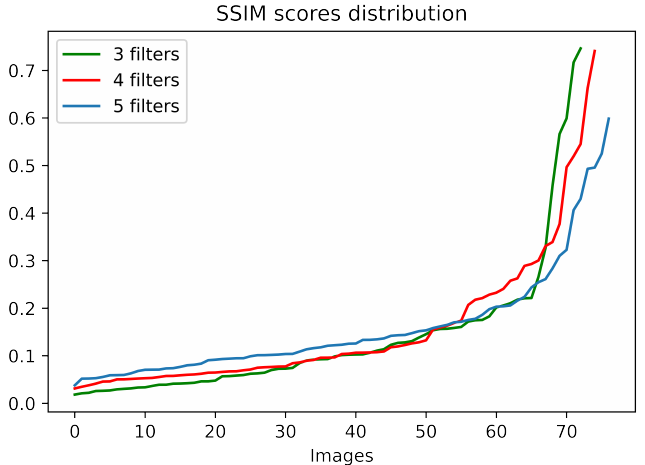
Figure 4. SSIM values distributions for the attacking images produced by sequences of 3, 4 and 5